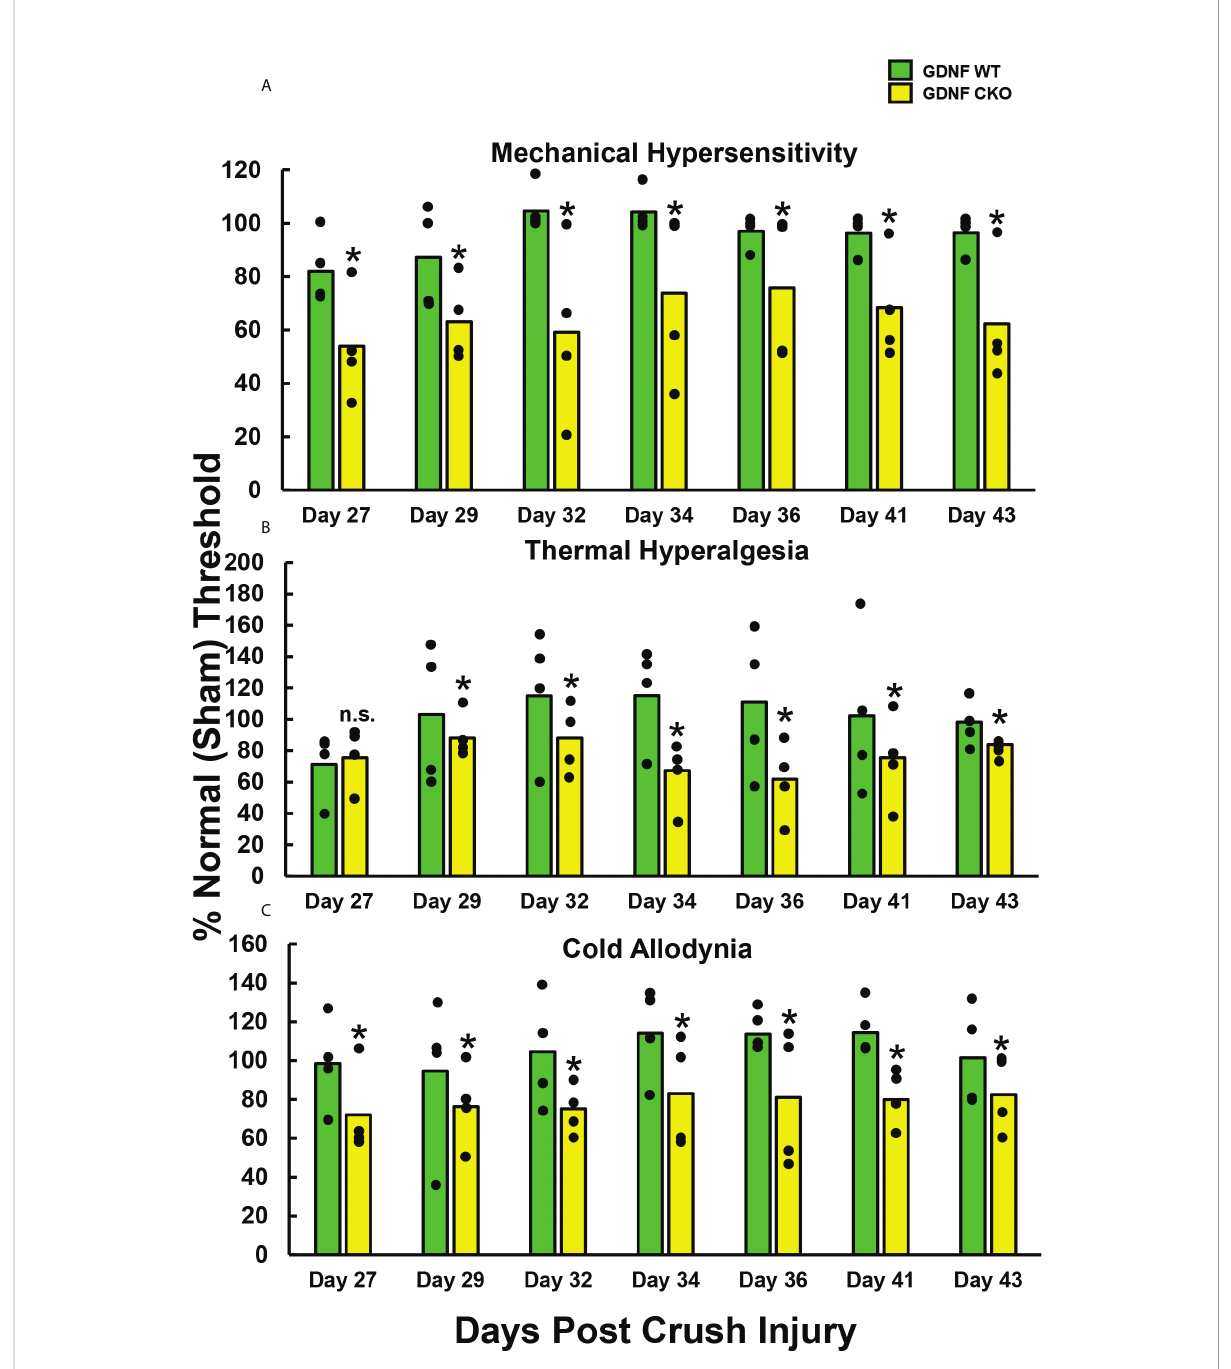
FIGURE 1 Chronic re fl exive neurobehavioral nociception in adult Gdnf CKO and WT mice after unilateral sciatic nerve crush injury. Bar histograms demonstrate mean re fl exive paw withdrawal thresholds from the same side as injured sciatic nerves relative to paw withdrawal thresholds from the uninjured (Sham control) side, expressed as % of the uninjured side. Statistically signi fi cant reductions in relative paw withdrawal thresholds to mechanical hypersensitivity (A) , thermal hyperalgesia (B) and cold allodynia (C) are observed in Gdnf CKO mice compared to age- and sex- matched Gdnf WT mice from day 29 following sciatic nerve crush injury for all modalities that persist up to 43 days post-injury, with signi fi cant differences seen with mechanical hypersensitivity and cold allodynia from day 27. *p < 0.05. N =